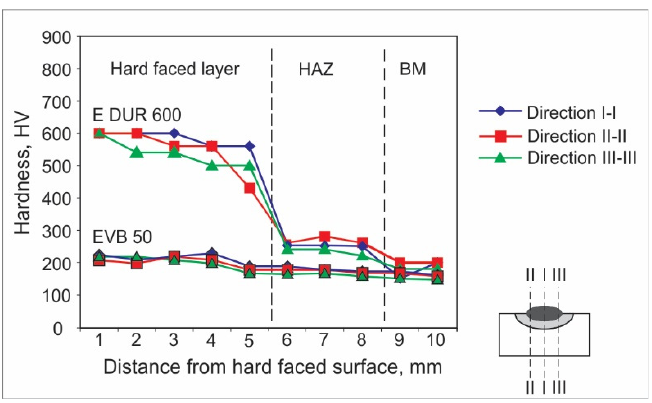
Figure 1. Hardness distribution in the hard-faced layer cross-section, BM-S235JR, FM-E DUR 600, EVB 50.